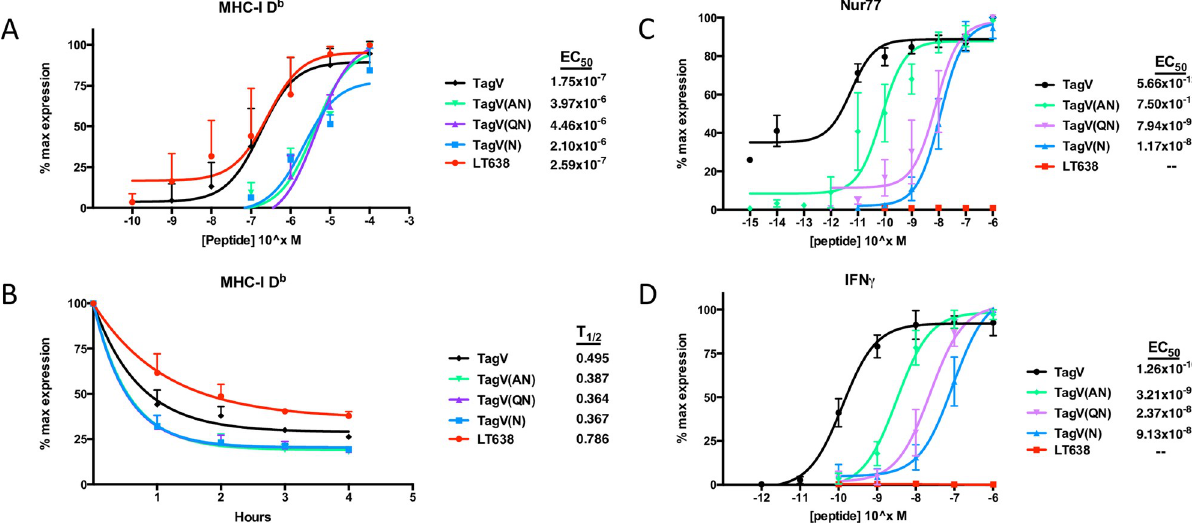
Fig 1. Characterizing the T cell response to analogues of a subdominant CD8 T cell epitope. (A) RMA/S cells were cultured overnight at 26˚C. Cells were incubatedwith the indicateddose of peptidefor 1 h at RT followedby incubationat 37C for 2 h. Table shows the EC 50 of each analoguepeptidefor MHC-I bindingand stabilization. (B) RMA/S cells were cultured overnight at 25˚C in 100 μ M of peptide. Cells were then resuspended in fresh media, incubatedat 37C, and sampledhourlyfor 4 h. Table shows the half-life of the analoguepeptidesfor bindingto MHC-I. (C-D) Splenocytes were isolatedfrom a na ï veTCR-V mouse and stimulatedwith TagV analogue peptides at the indicated concentrations for 5 h at 37˚C. NuclearNur77 (C) and intracellular IFN γ expression(D) shown. Table shows the EC 50 of each analogue peptidefor expressionof these activationmarkers. All data plotted as percent of maximal expression ± SD.